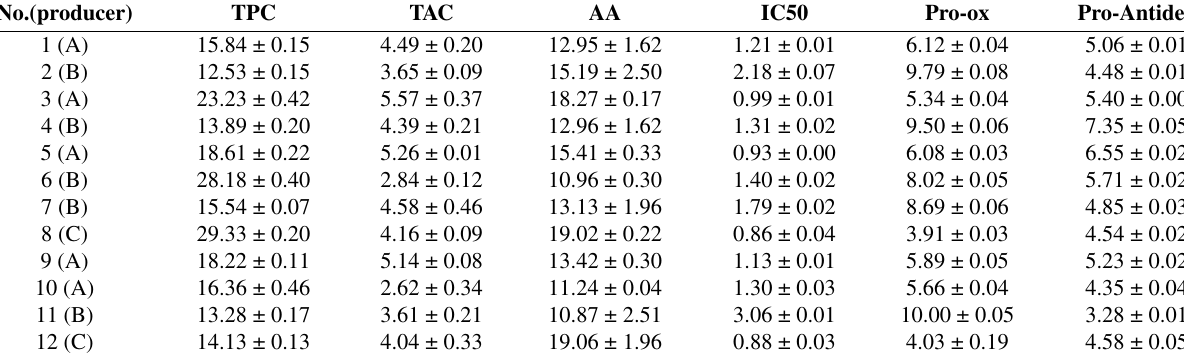
Table 2. The total phenolic content (TPC – mg GAE/g fruit tea), total anthocyanins content (TAC – mg Cy-3-gly/g fruit tea), antioxidant activity (AA- mg AAE/g fruit tea), IC50 (mg/mL), pro-oxidant activity (mg/mL) and Pro-Antidex of the analyzed teas (n = 9). No.(producer) TPC TAC AA IC50 Pro-ox